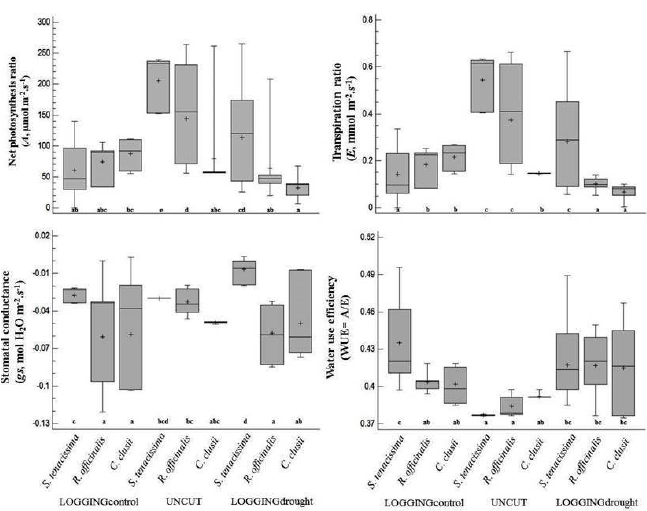
Figure 3. Multifactor ANOVA test which includes the mean value and standard error according to the significant factors using Tukey’s HSD for the net photosynthesis ratio ( A , μmol m −2 s −1 ), transpiration ratio ( E , mmol m −2 s −1 ), stomatal conductance ( gs